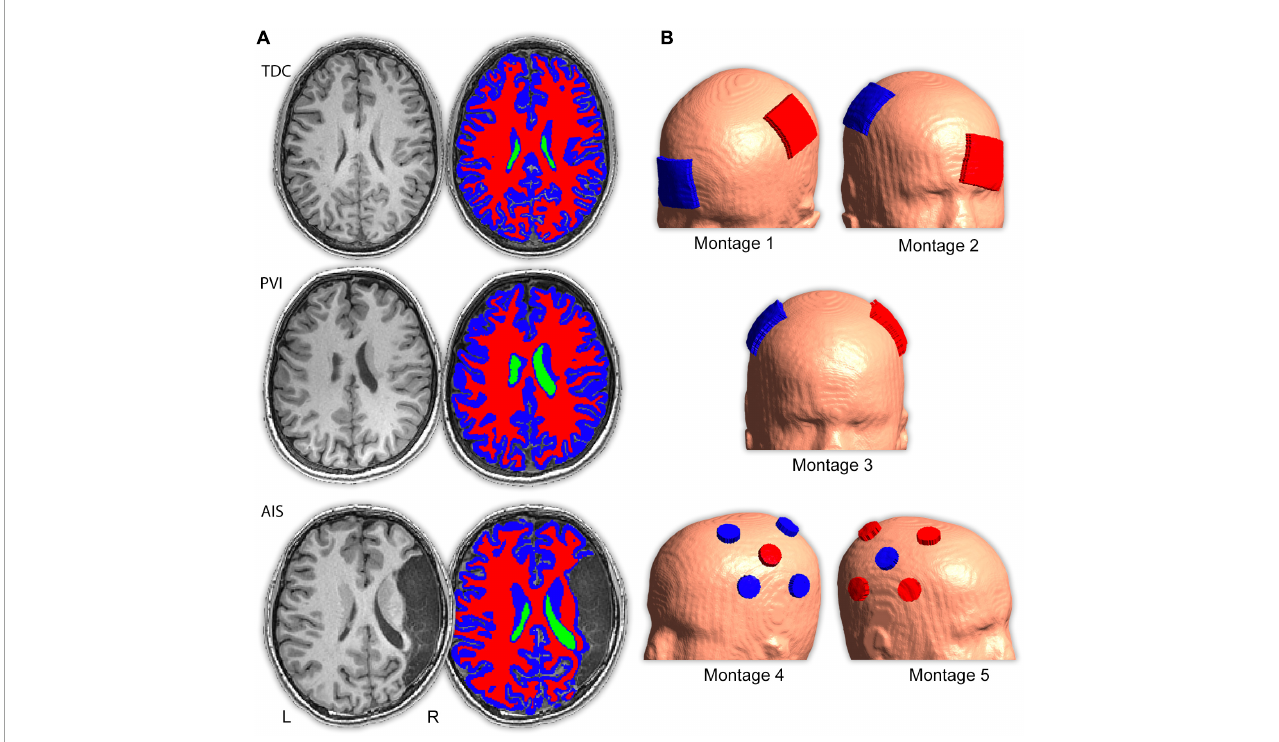
FIGURE1 Image processing procedure and montage electrode placements. (A) T1- and T2-weighted images were segmented into five tissue types (only T1-weighted images, ventricle, gray and white matter masks are shown here) and converted to a tetrahedral mesh via the headreco command. Three example participants are shown; a typically developing control (TDC), a child with periventricular venous infarction (PVI) and a child with arterial ischemic stroke (AIS). Areas of cerebrospinal fluid (CSF)-filled lesion and dilated ventricles were coded as CSF. (B) Five transcranial direct-current stimulation (tDCS) montages targeted at enhancing motor function were simulated. Electrode positions are illustrated using a child with a left hemisphere stroke. Red electrodes denote anode locations, blue electrodes denote cathode locations.